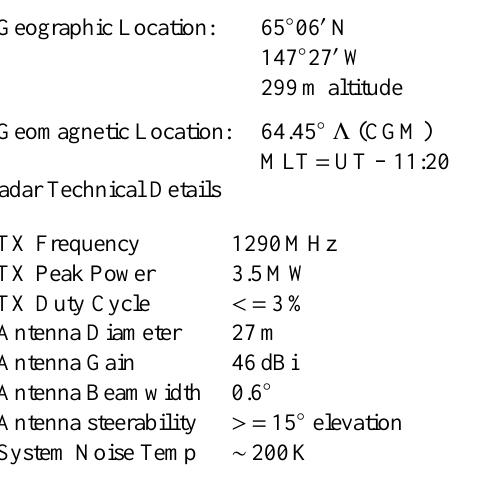
Figure 7. Polar view of the nominal F-region fields of view of the high-latitude ISRs. Included are the fan-shaped fields of view of the SuperDARN radars and color-coded contours of electric